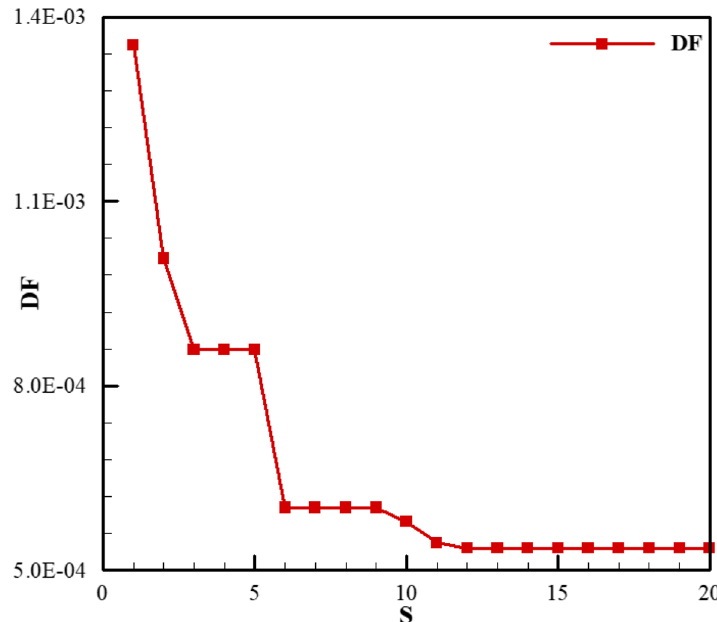
Fig. 14 Convergence process of the optimized objective function